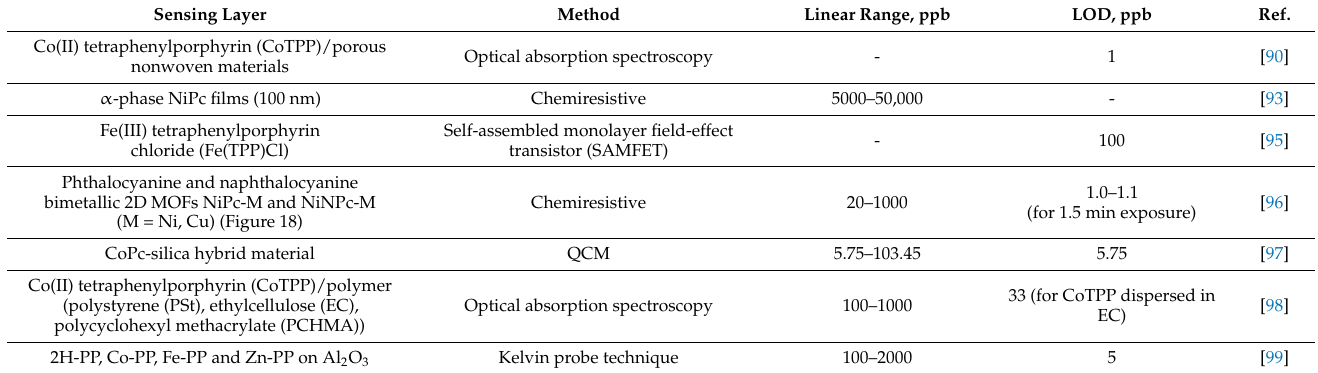
Table 2. Examples of phthalocyanine and porphyrin-based sensors used for the detection of gaseous